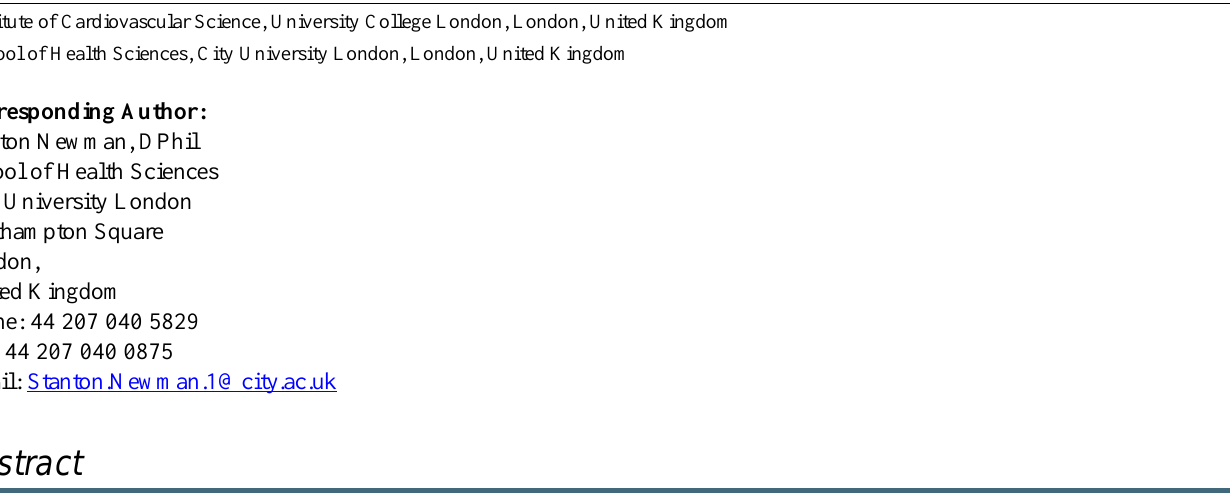
mobile telehealth; self-management; mixed-method design; diabetes; glycated hemoglobin (HbA1c); health-related quality of life; intervention fidelity; behavior